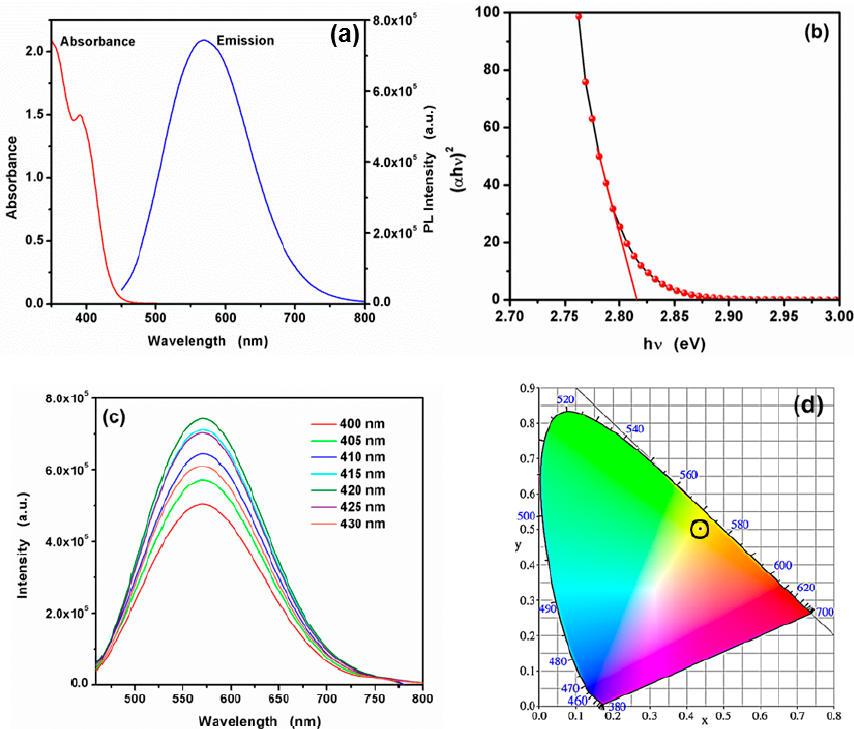
Figure 5. ( a ) The UV-vis absorbance (red line), the emission spectra (blue line) of the as-synthesized CA-CdS QDs. ( b ) ( α h υ ) 2 vs . h υ plot of CdS QDs for the determination of band gap. ( c ) The excitation-dependent emission spectra of CA-CdS QDs and ( d ) The CIE 1931 coordinates.